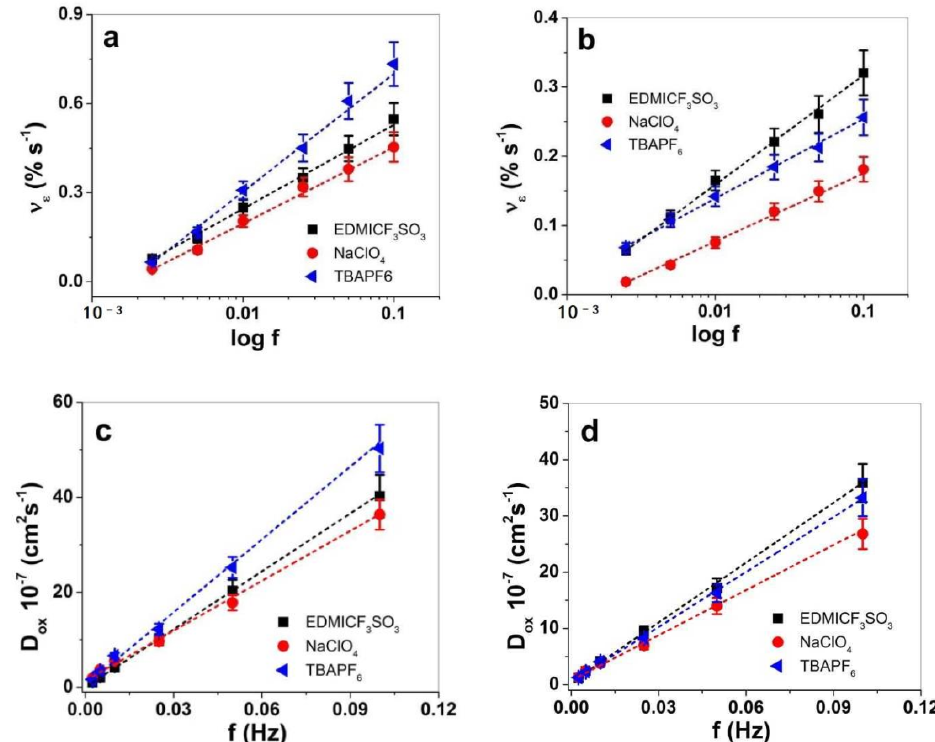
Figure 5. Square potential steps at applied frequency 0.0025 Hz (two subsequent cycles 3rd − 4th) in potential range 1.0 V to − 0.55 V (E, dashed line) in electrolytes EDMICF 3 SO 3 -PC (black curve), Figure 6. Square potential steps of PPy at applied potential range 1.0 V to − 0.55 V and frequencies NaClO 4 -PC (red curve) and TBAPF 6 -PC (blue curve) showing strain of ( a ) PPy-PEO and ( b ) PPy/DBS 0.0025 Hz to 0.1 Hz in propylene carbonate solvent with salts EDMICF 3 SO 3 ( (cid:4) ), NaClO 4 ( • ) and films. The strain against charge densities in electrolytes EDMICF 3 SO 3 ( ■ ), NaClO 4 ( ● ) and TBAPF 6 ( ◄ ) for ( c ) PPy-PEO and ( d ) PPy/DBS films. The dashed lines represent the linear fit shown here for TBAPF 6 ( ) showing the strain rate ν e against logarithmic scale of frequencies of ( a ) PPy-PEO and orientation only. ( b ) PPy/DBS. The diffusion coefficients at oxidation D ox determined from Equations (1) and (2) of PPy-PEO are shown in ( c ) and those of PPy/DBS presented in ( d ) against frequencies f. The dashed lines represent the linear fit and are shown for orientation only. Table 2. Strain ε , strain rate ν ε and diffusion coefficients at oxidation D ox of PPy-PEO and PPy/DBS in electrolytes EDMICF 3 SO 3 -PC, NaClO 4 -PC and TBAPF 6 -PC at frequency 0.1 Hz. Electrolytes in